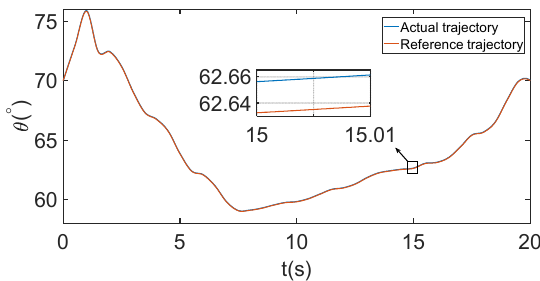
Figure 14. Pitch angle tracking result by LADRC controller.